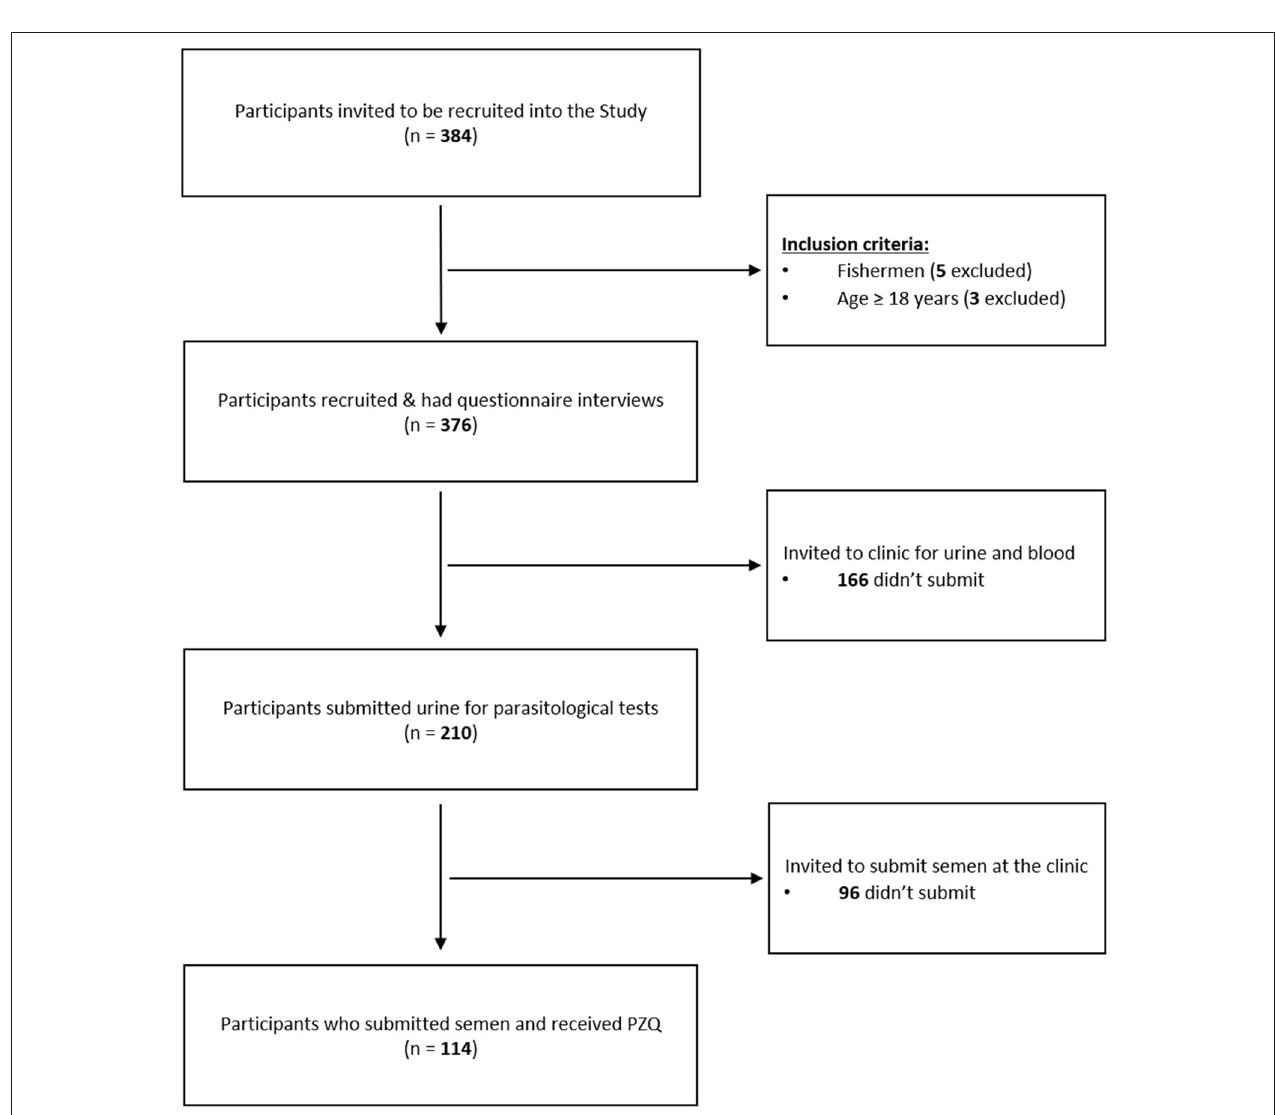
FIGURE 3 | Consort diagram showing the outline of the